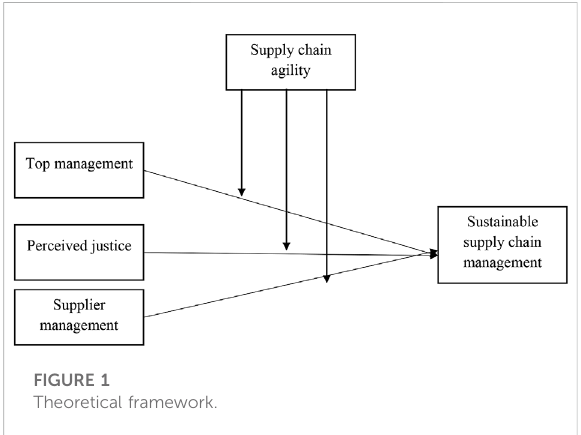
FIGURE 1 Theoretical